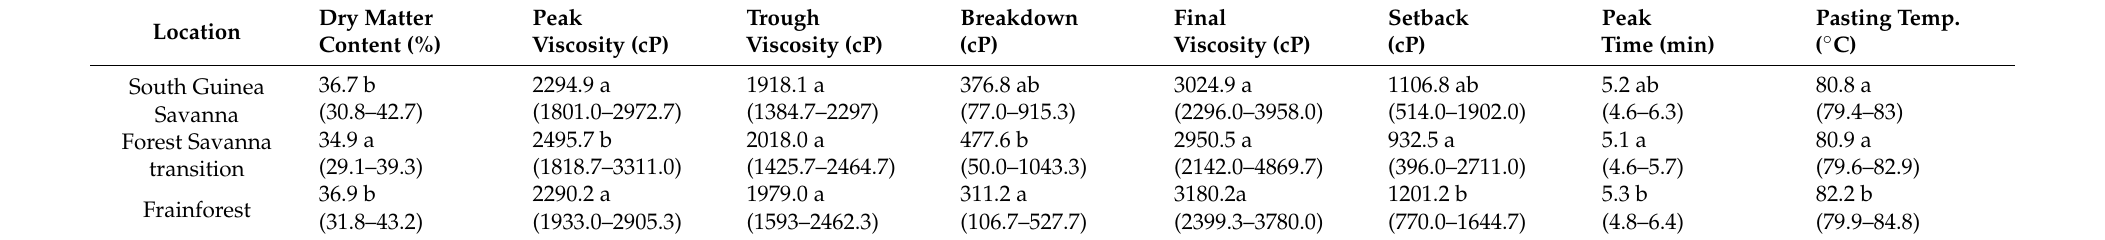
Table 3. Mean (and range) of dry matter content and pasting properties at different